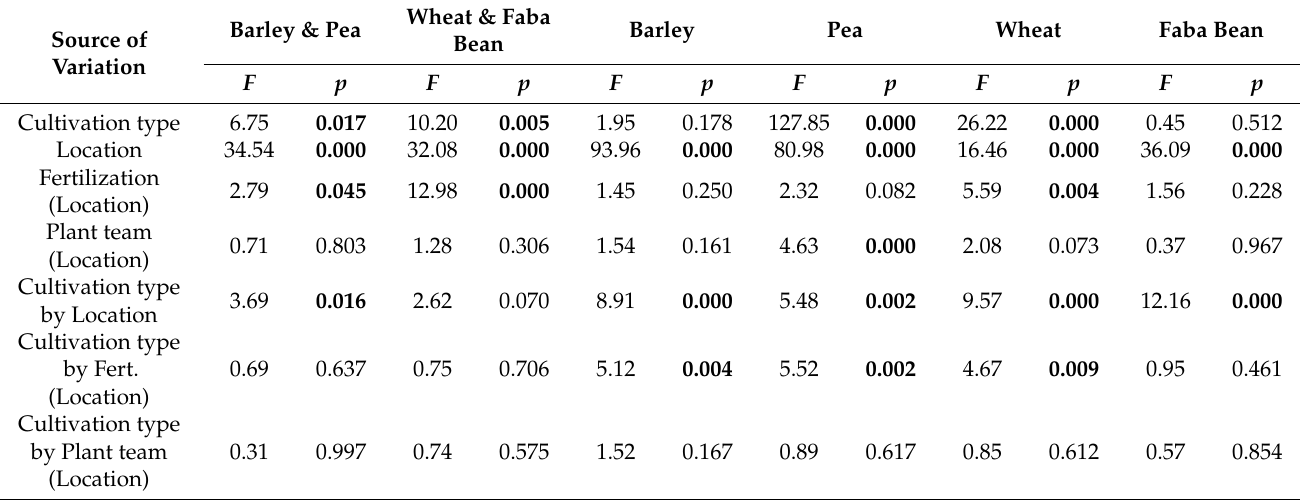
Table 3. Linear Mixed Model analysis results for fixed effects of cultivation type (sole crop and intercrop, df = 1), location ( df = 5), fertilization level (low, high) within location ( df = 5 for pea-barley and df = 4 for faba bean-wheat), plant team within location ( df = 27 for pea-barley and df = 14 for faba bean-wheat), and the interactions between cultivation type and location, fertilization and plant team, respectively, on the yield difference (Delta; log e transformed values) between the two cultivation years 2017 and 2018. Separate analyses were done for crop stand-based data (barley-pea, wheat-faba bean) and single crop-based data (barley, pea wheat and faba bean grown as sole crops and their respective intercrops). F —critical value for F-statistics, p —significance (significant: p < 0.050 in bold), df degrees of freedom.